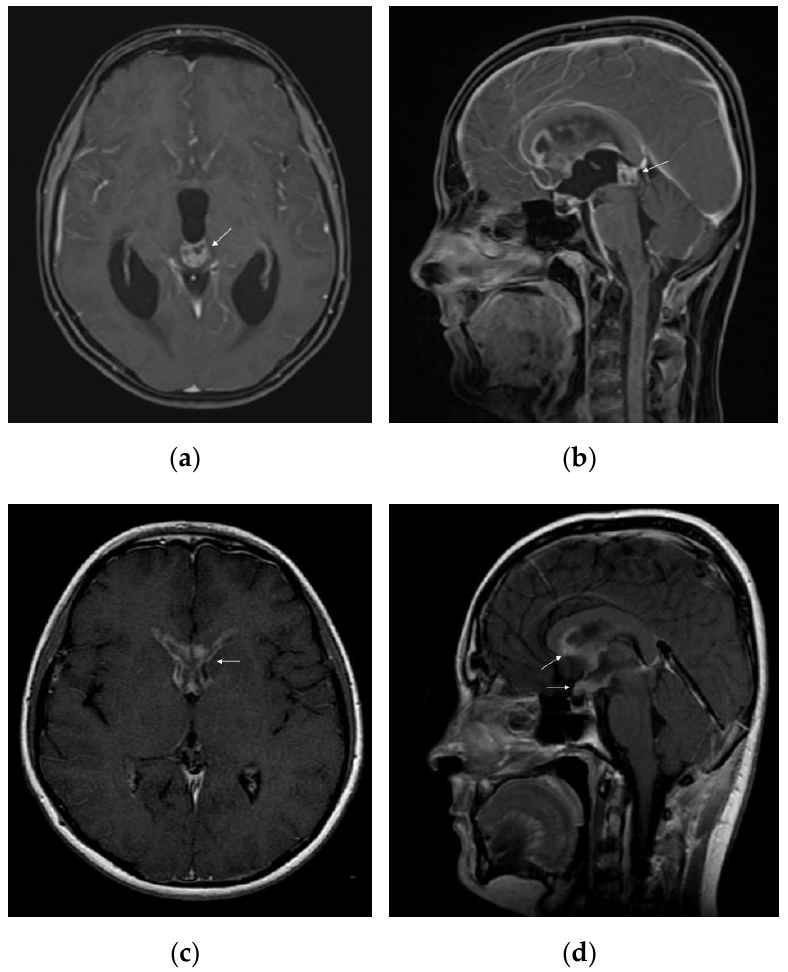
Figure 2. MRI features of intracranial germinoma in a teenage patient: ( a ) pineal germinoma: heterogeneous contrast enhancement on axial gadolinium-enhanced T1-weighted image, with a tendency to cardioid shape; ( b ) pineal germinoma: heterogeneous contrast enhancement on sagittal gadolinium-enhanced T1-weighted image; ( c ) postoperative disseminated disease: bilateral nodular enhancement of anterior horns of the lateral ventricles on axial gadolinium-enhanced T1-weighted image; ( d ) postoperative disseminated disease: nodular enhancement of the hypothalamus, optic chiasm, mammillary bodies, and corpus callosum on sagittal gadolinium-enhanced T1-weighted image. Basal ganglia and thalamus germinomas may present variable neuroimaging features (cystic lesion, peritumoural oedema, calcification, intratumoural haemorrhage,